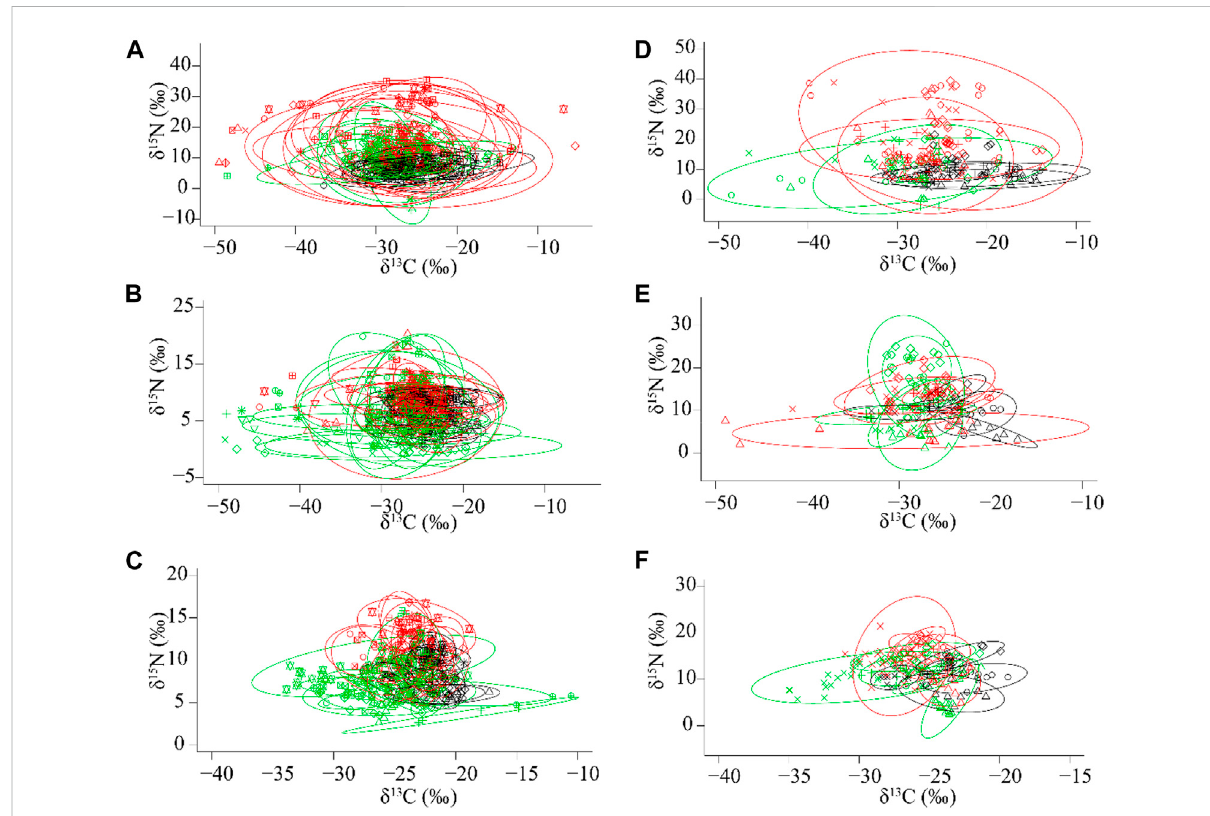
FIGURE 4 The isotopic variances illustrated by standard ellipse area (SEA c , ‰ 2 ) for (A) basal resources, (B) macroinvertebrates, (C) fi sh at woodland sites, and (D) basal resources, (E) macroinvertebrates, (F) fi sh at urban sites. Black, red, and green ellipses and symbols represented spring, autumn, and winter,